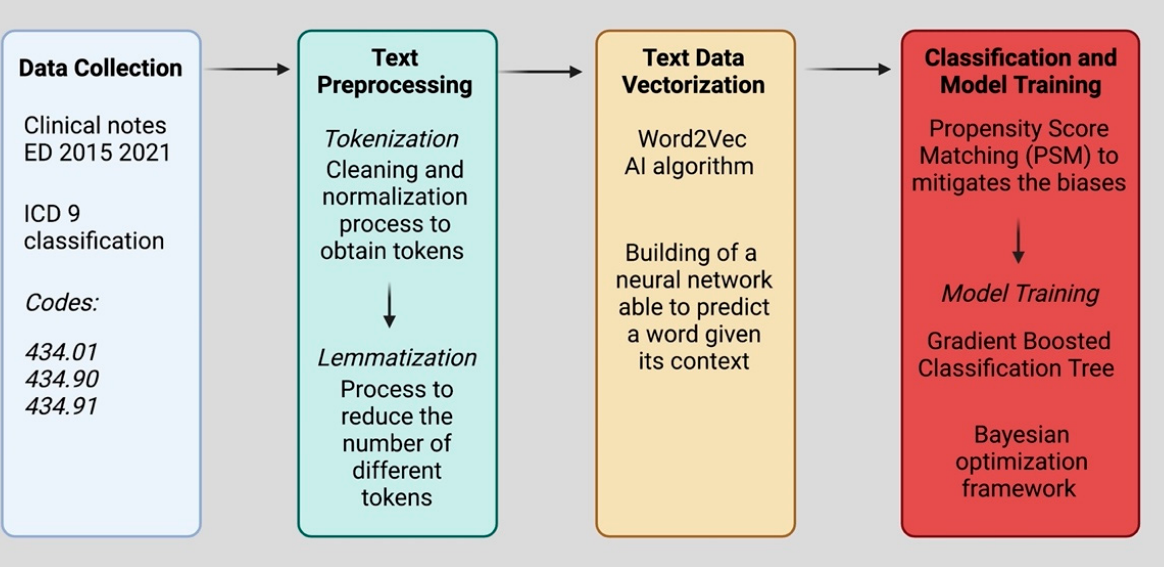
Figure 2. Flowchart of the data collection and processing. ED: emergency department; ICD-9: International Classification of Diseases 9th revision; AI: artificial intelligence.